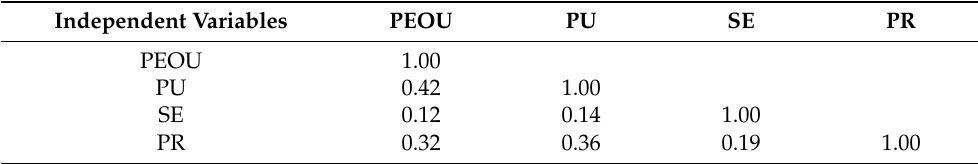
Table 2. Correlation coefficients.